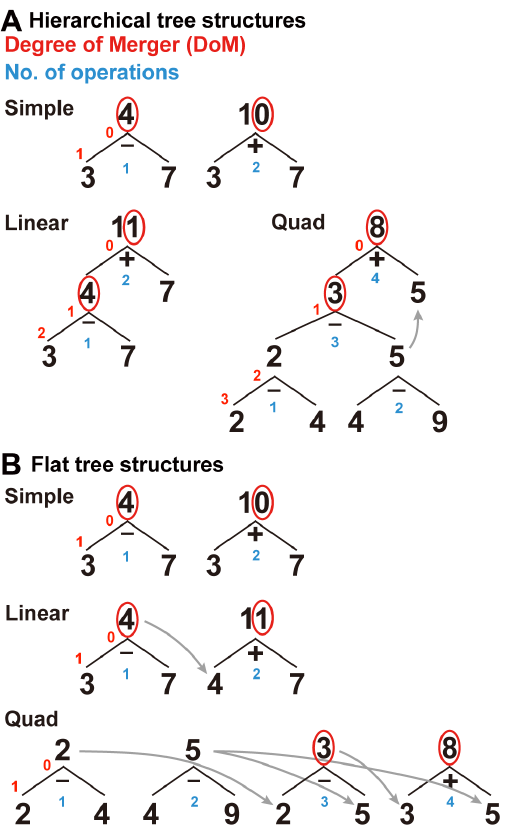
Figure 2. Hierarchical and flat tree structure models for arithmetic calculations. For each example shown in Figure 1, an entire calculation process is represented by either hierarchical (A) or flat (B) tree structure models, where the lowest and leftmost branch corresponds to the first arithmetic calculation performed. A digit in black at each nonterminal node is obtained from an arithmetic operation (e.g., + or 2 ) indicated just below each node, where ‘–’ denotes a single operation of subtracting a smaller value from a larger value. The digits in red denote the DoM at individual nodes, where a reference point of zero is at the top node. The digits in blue denote ‘‘number of operations.’’ A gray arrow denotes corresponding digits generated temporarily in a calculation. The stored digits are circled in red, as shown in Figure 1. In the hierarchical tree structure model, each tree structure is based on recursive computation. Under the Linear condition, the hierarchical representation of the given example is: [|3 2 7| + 7] =11. Under the Quad condition, the hierarchical representation of the given example is: [||2 2 4| 2 |4–9|| + 5] =8.